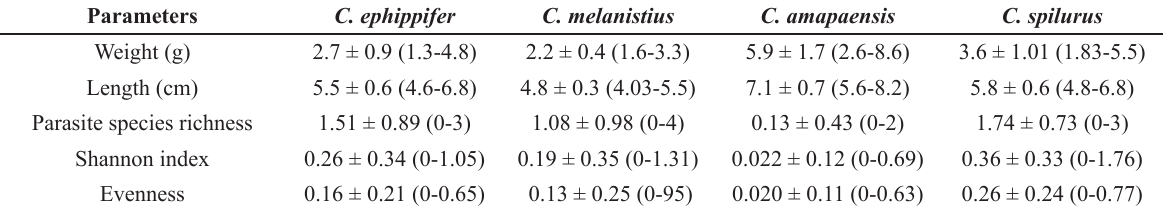
Diversity descriptors and body parameters for parasite communities in four species of Corydoras endemic to the eastern Amazon (Brazil).